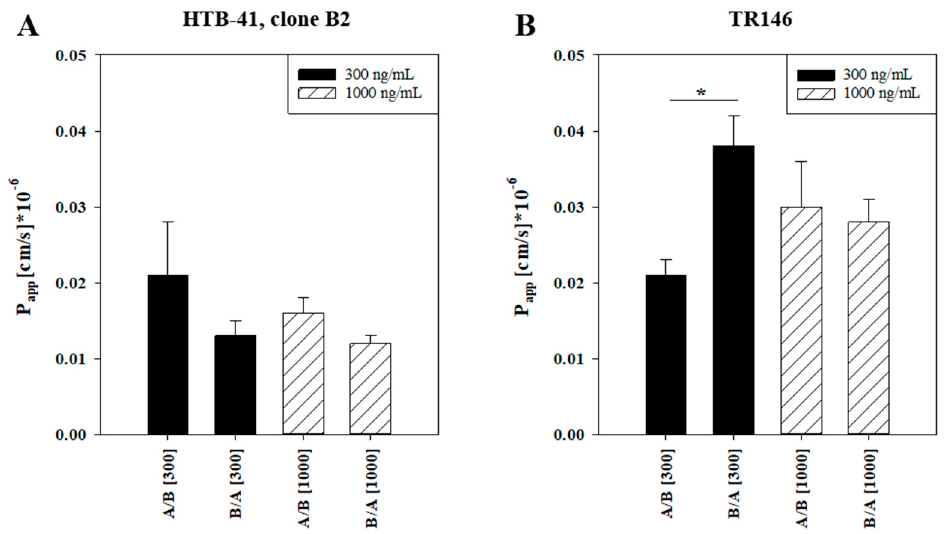
Figure 5. Apparent permeability coefficients P app for 300 ng/mL or 1000 ng/mL ferritin applied on the apical side (transport A/B) or basolateral side (transport B/A) ( A ) in the salivary gland epithelium model based on clone B2 ( n = 10–11 from three independent experiments) or ( B ) in the oral mucosa epithelial model based on TR146 ( n = 10–16 from three independent experiments). Data are displayed as mean ± SEM, statistical analysis was performed as one-way ANOVA with post-hoc Dunn’s test, α = 0.05, * p < 0.05.